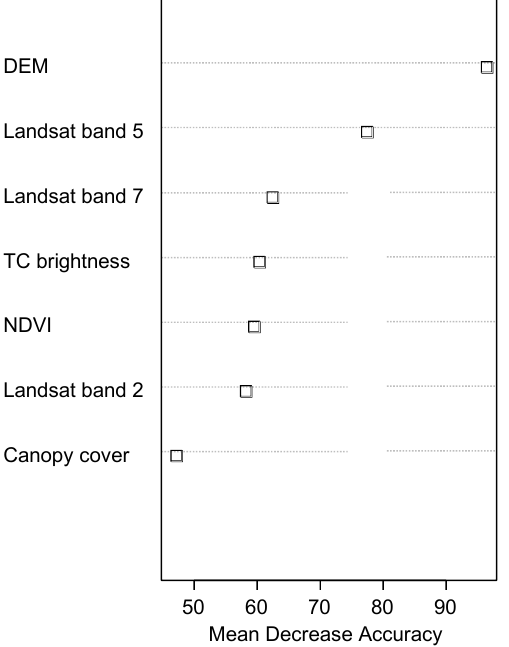
Figure A1. This figure identifies the most important predicting variables in the Random Forest